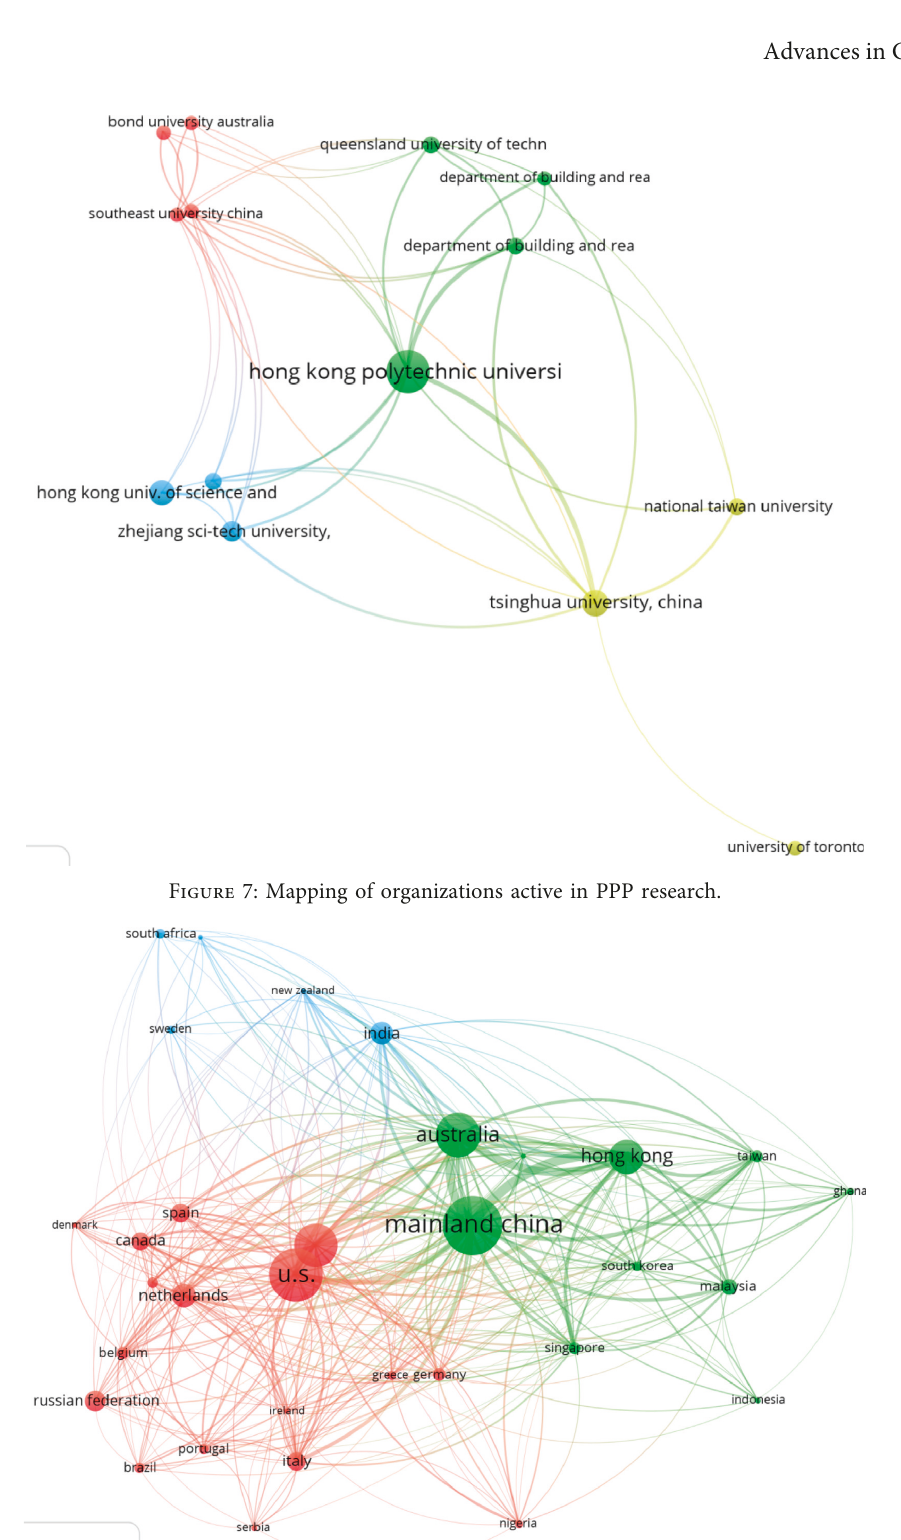
Figure 8: Mapping of countries/regions where PPP researchers were